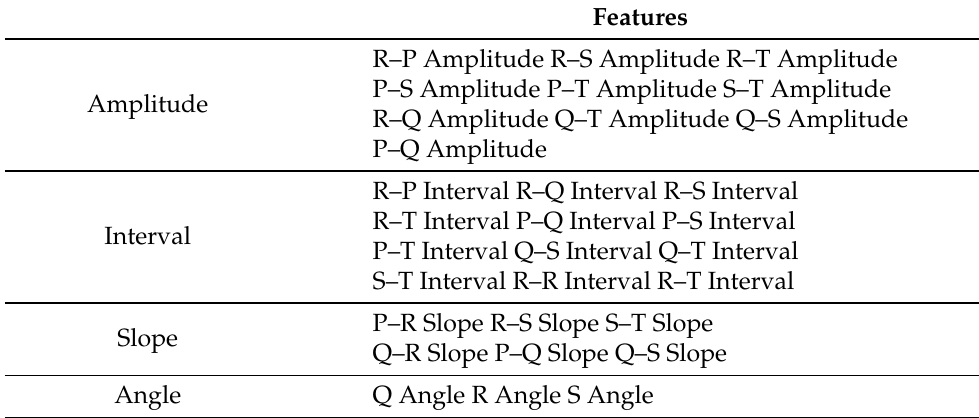
Table 1. Features extracted from an electrocardiogram (ECG) signal.